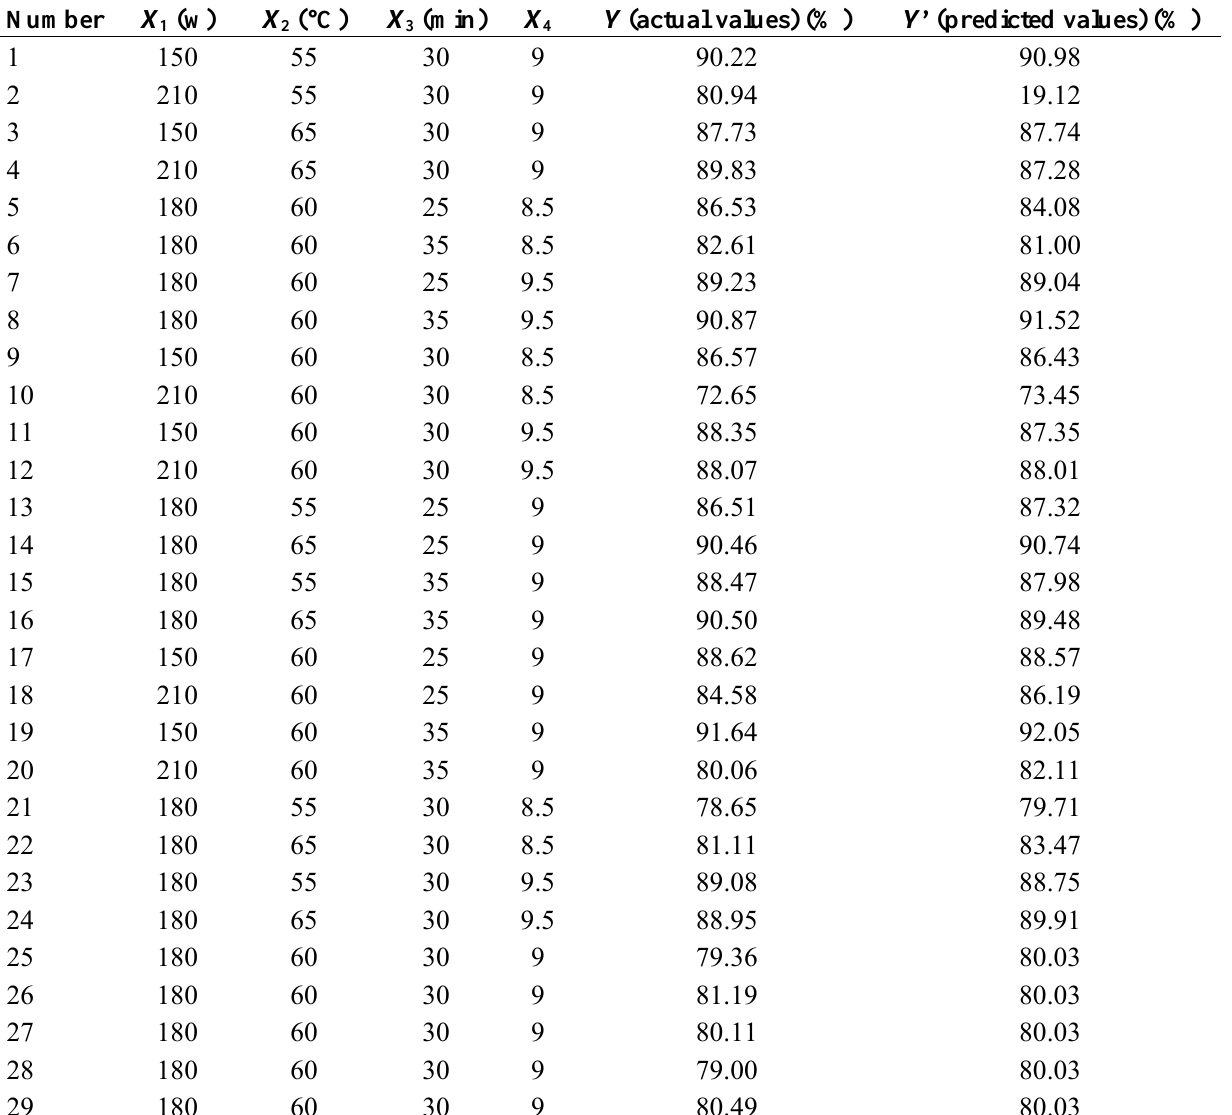
Table 1. Response surface methodology (RSM) experiment design and results.